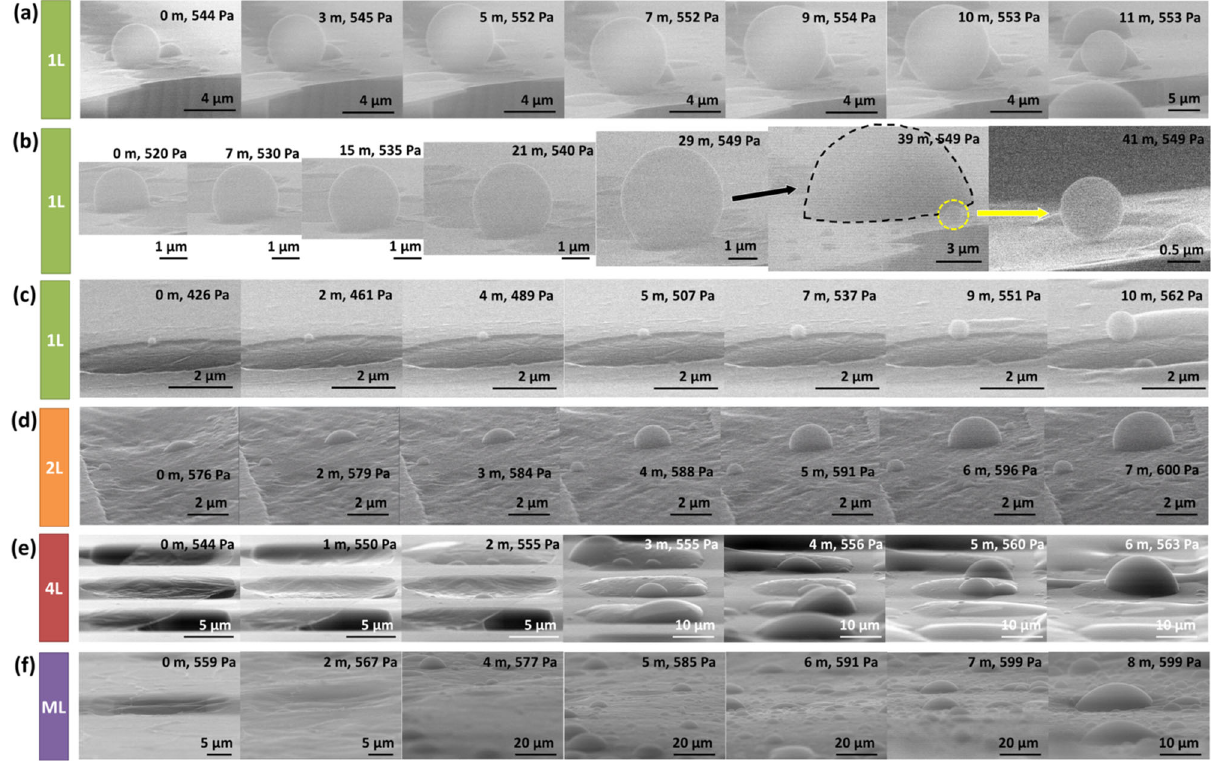
Fig. 3 ESEM experimental observations of condensation. a – c 1 L sus , d 2 L sus , e 4 L sus , and f ML sus in time (see accompanying Supplementary Movies 1 to 6). Non-wetting water droplets are only observed on suspended graphene (1 L sus ). We note here that experimental observations on a , b and c